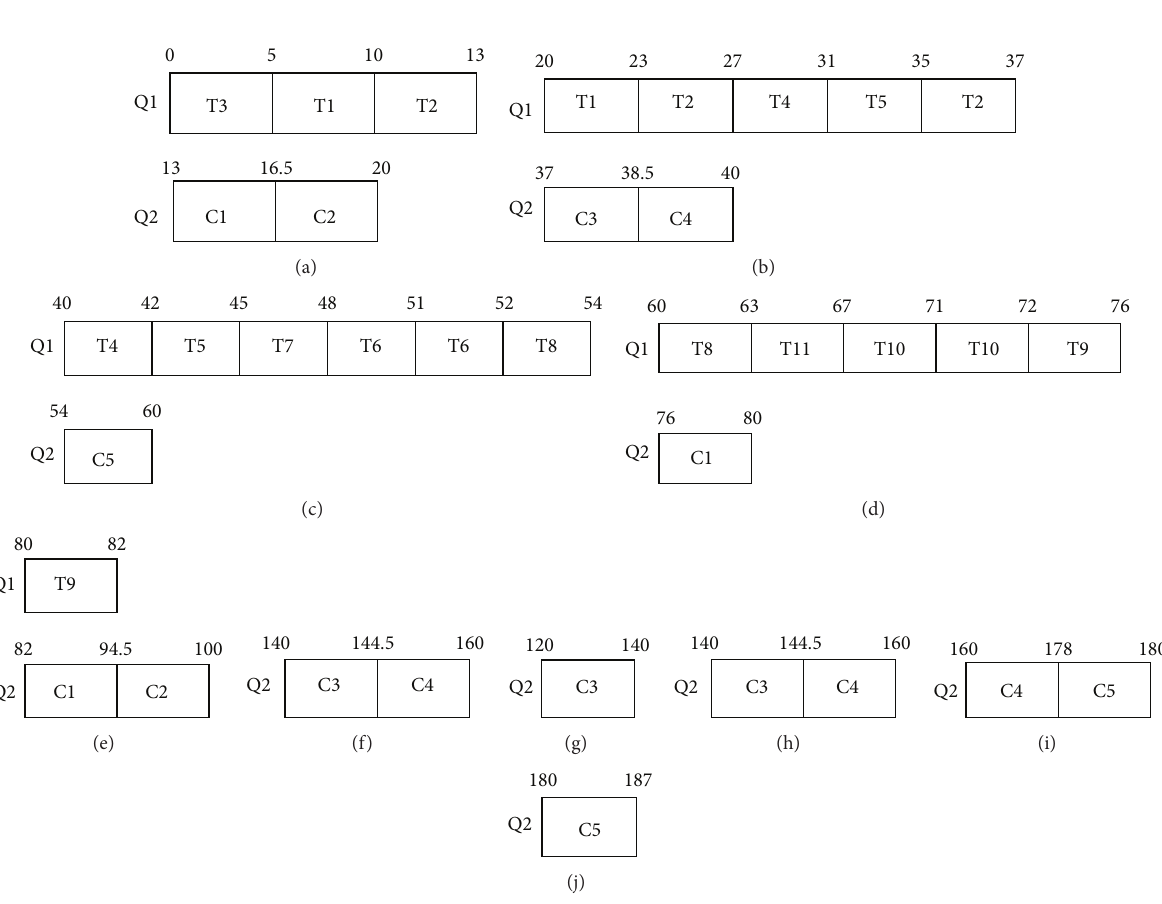
Figure 8: (a) 1st cycle of CPU (FMLQ), (b) 2nd cycle of CPU (FMLQ), (c) 3rd cycle of CPU (FMLQ), (d) 4th cycle of CPU (FMLQ), (e) 5th cycle of CPU (FMLQ), (f) 6th cycle of CPU (FMLQ), (g) 7th cycle of CPU (FMLQ), (h) 8th cycle of CPU (FMLQ), (i) 9th cycle of CPU (FMLQ), and (j) 10th cycle of CPU